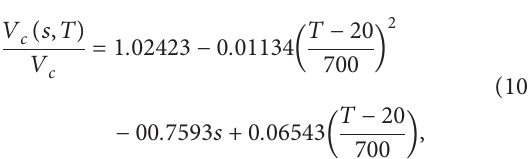
Figure 18: Relation between relative ultrasonic wave velocity and